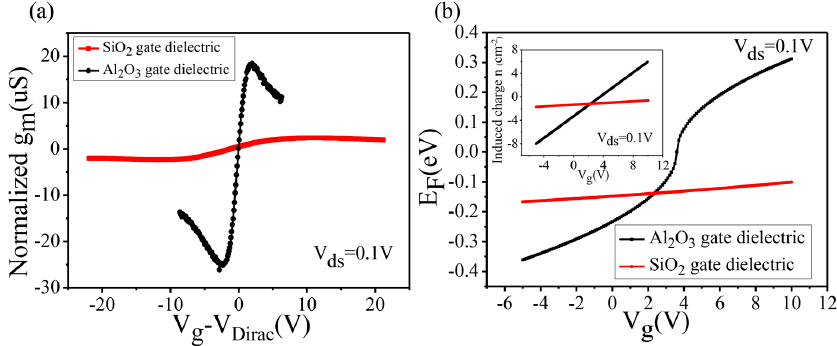
Figure 5. ( a ) g m – V g curves of graphene FETs on different substrates. ( b ) E F – V g curves of graphene FETs on different substrates. The inset shows the variation tendency of the induced charge against gate